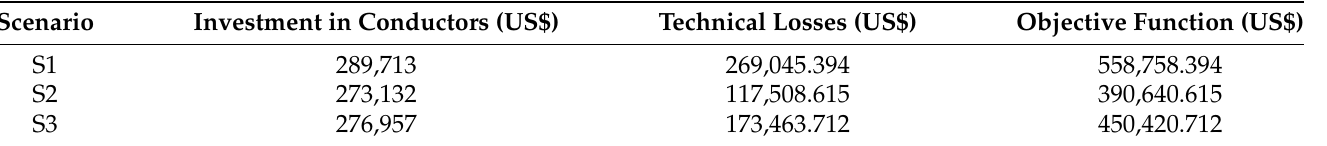
Table 16. Investment and operating costs in test system